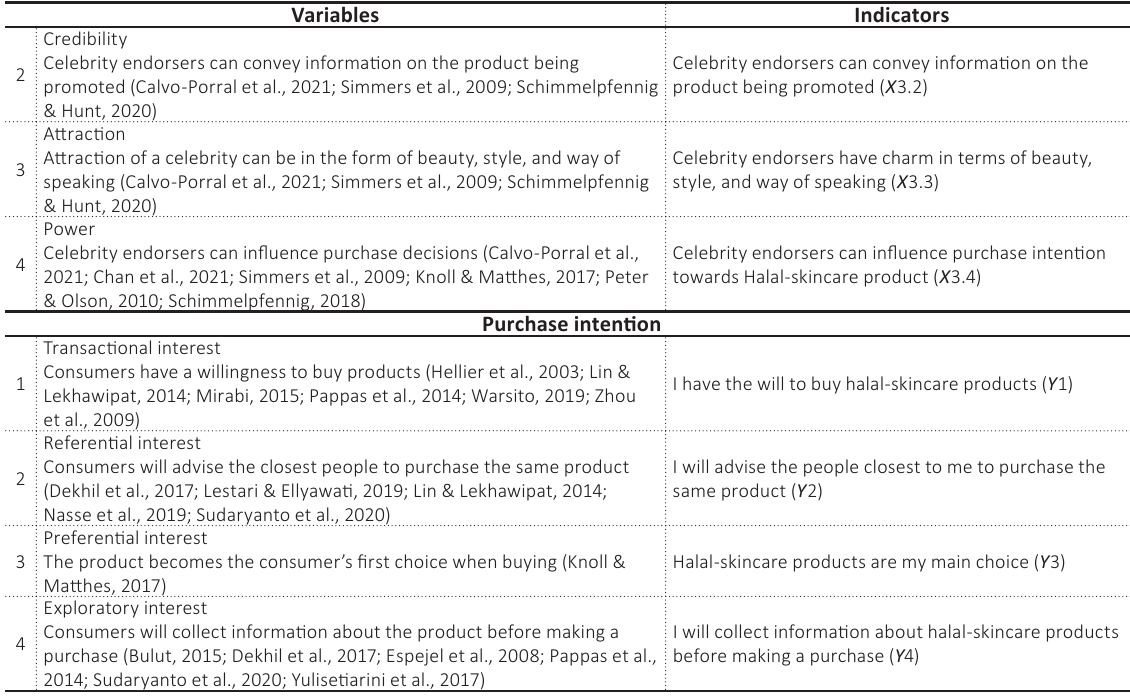
Table 1 (cont.). Variables and indicators